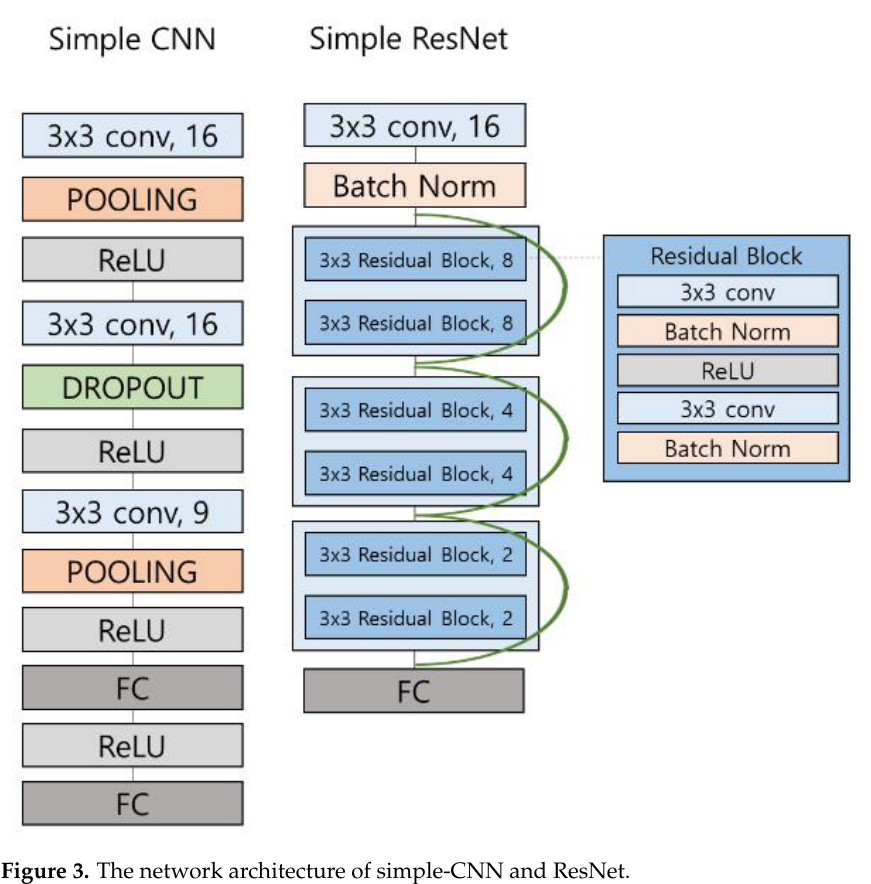
Figure 3. The network architecture of simple-CNN and ResNet.